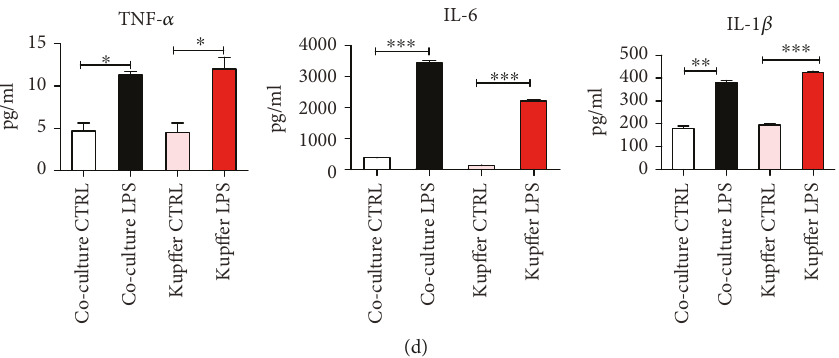
Figure 4: Kup ff er cells secrete hematopoiesis-promoting cytokines and promote the di ff erentiation of liver HSPCs. (a) Collagenase IV was used to digest the liver tissue, and kup ff er cells were isolated by density gradient centrifugation. The cells were then inoculated into 24-well plates ( 1 × 10 5 cells/well). Kup ff er cells were further puri fi ed by cell adhesion selection. After culturing for 30 min, the supernatant was absorbed and washed three times with 1 × PBS, then replaced with fresh DMEM medium (500 μ L). Cell culture supernatants were collected at 24 h and 48 h. An ELISA was used to detect the levels of SCF, IL-6, and IL-3 in the kup ff er cell culture supernatants. The bars represent the mean ± SEM of three independent experiments. (b) The sorted liver LSK cells were seeded onto kup ff er cell monolayers in the presence of SCF (50 ng/mL), and fresh kup ff er cells were replaced every three days. The cocultured cells were collected and analyzed by fl ow cytometry on days 7 and 14. The proportion of lymphocytes (CD3 + T, CD19 + B, and NK1.1 + NK cells) and myeloid cells (CD11b + cells) gated from total cells in the coculture system was detected by fl ow cytometry on day 14. (c) Statistical chart of the proportion of CD3 + , CD19 + , NK1.1 + , and CD11b + cells among the total coculture cells in the kup ff er+LSK +SCF and kup ff er+LSK+SCF+LPS coculture groups. (d) The level of proin fl ammatory factor IL-6, TNF- α , and IL-1 β in the coculture supernatants from kup ff er+LSK+SCF, kup ff er+LSK+SCF+LPS, kup ff er+CTRL, and kup ff er+LPS groups was detected by ELISA. The data are represented as the mean ± SEM . ns: not signi fi cantly di ff erent. ∗ P < 0 05 ; ∗∗ P < 0 01